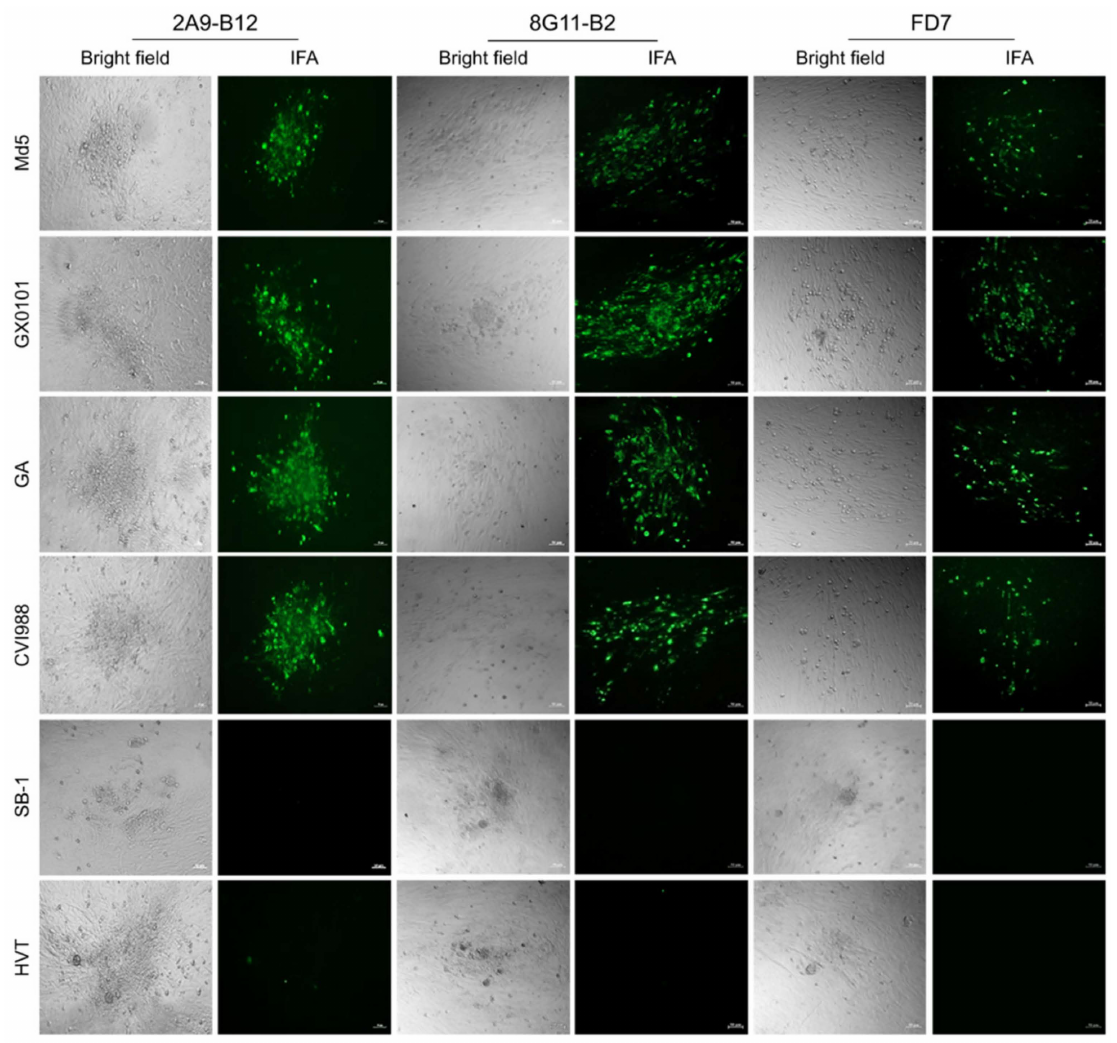
Figure 5. Cross reactions of mAbs 2A9-B12 and 8G11-B2 to the viral plaques produced by different types of MDVs detected by IFA staining. The reaction spectrums of newly developed Meq mAbs to different types of MDV and HVT were determined by IFA staining. The anti-Meq mAb FD7 served as a positive control. Bright field, images of virus plaques under regular light; IFA, immunofluorescence assay. (Scale bar = 50 µ